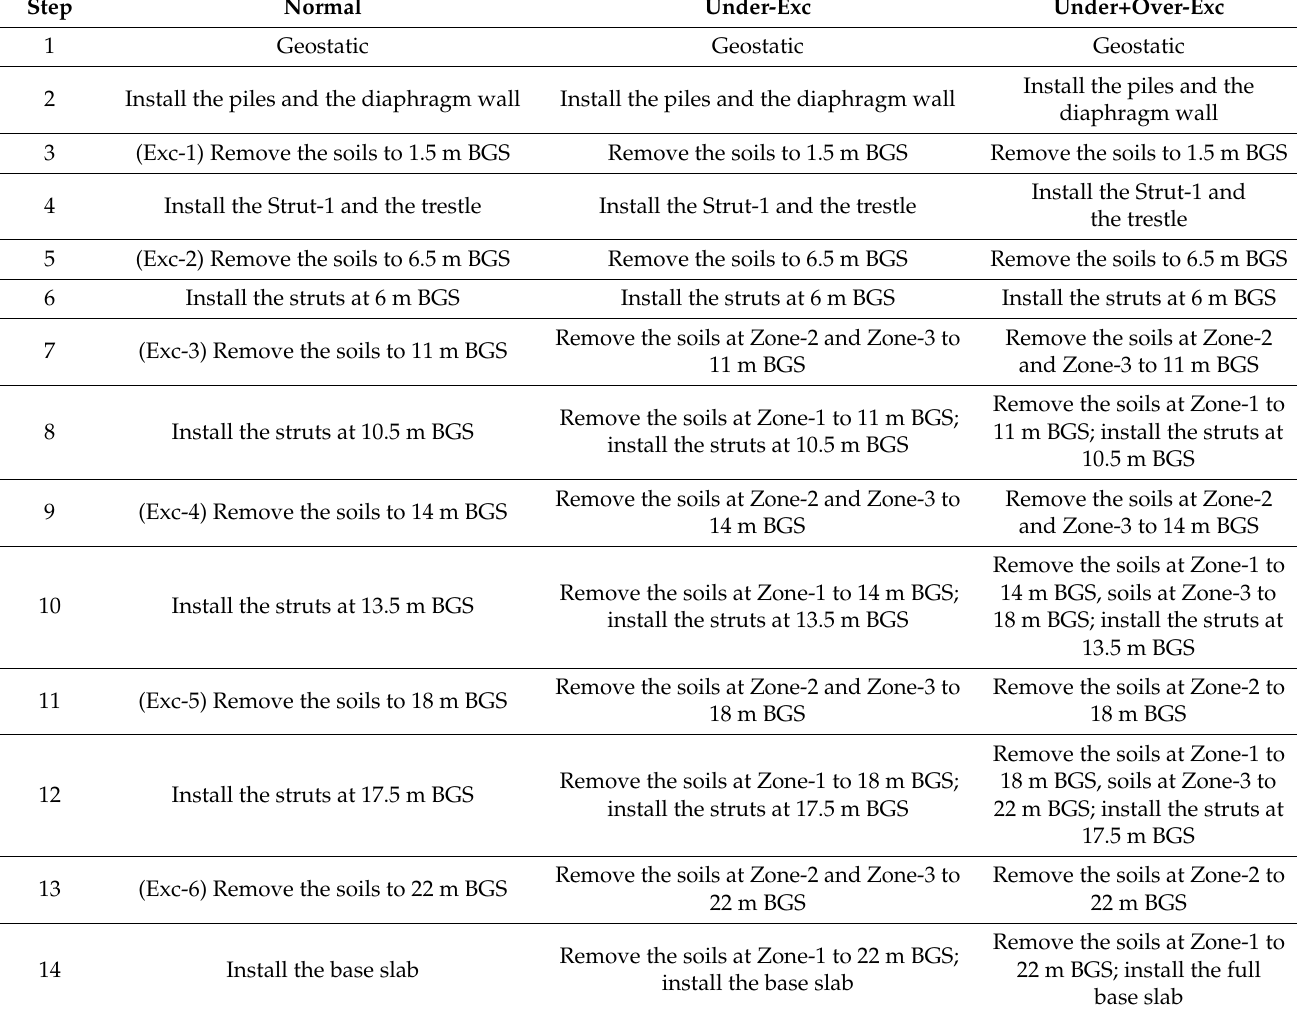
Table 2. Strategy of analyses and construction